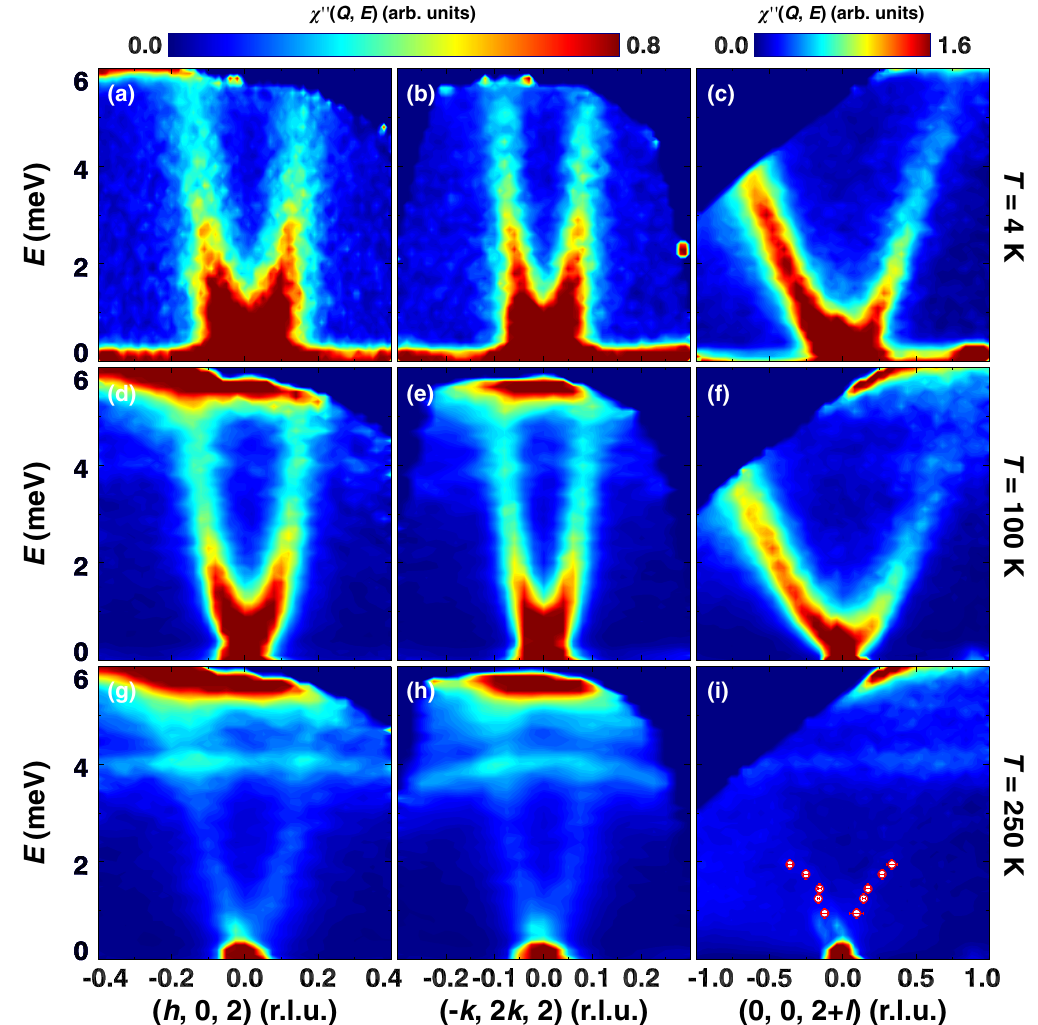
¼ 8 . 9 meV at 4 K (a) – (c), 100 K (d) – (f), and 250 K (g) – (i), respectively. The FIG. 4. Low- E spin excitation spectra obtained with E i spectra in the left [(a), (d), and (g)], middle [(b), (e), and (h)], and right [(c), (f), and (i)] columns represent the spin excitations along [1, 0, 0], ½ − 1 ; 2 ; 0 (cid:4) , and [0, 0, 1] directions, respectively. The integration ranges of k , h , and l when necessary were − 0 . 04 ≤ k ≤ 0 . 04 , −